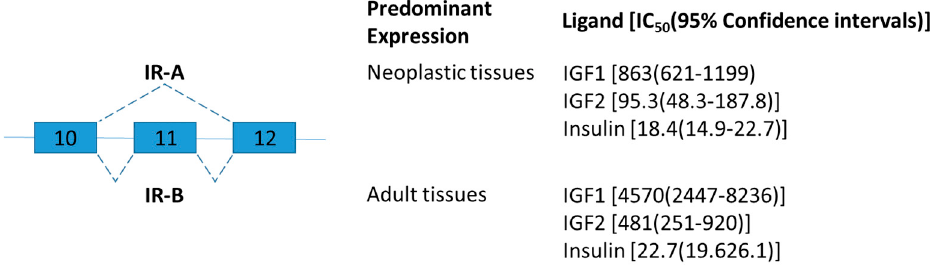
Figure 1. Schematic figure representing insulin receptor (IR) splice variants. Exons 10–12 are represented by boxes. Alternative splicing sites are depicted by connections with dashed lines. The insulin receptor isoform A (IR-A) lacks exon 11 which codes for a 12-amino acid segment present at the C terminal of the alpha chain of the isoform B (IR-B). The ligand binding affinity of human IR-A and IR-B is expressed as IC 50 values in picomol [35].